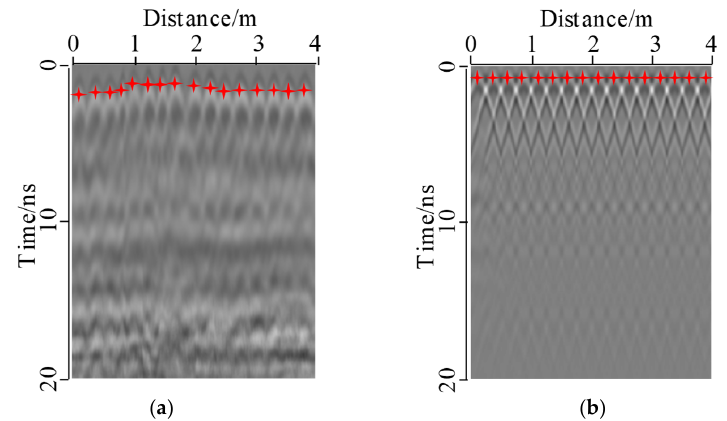
Figure 6. Comparison between simulation and measurement: ( a ) Measured image, ( b ) Forward im ‐ age. One steel bar was set in the range of four meters, and obvious diffraction waves were observed, which shows that the establishment of the forward model is reasonable.